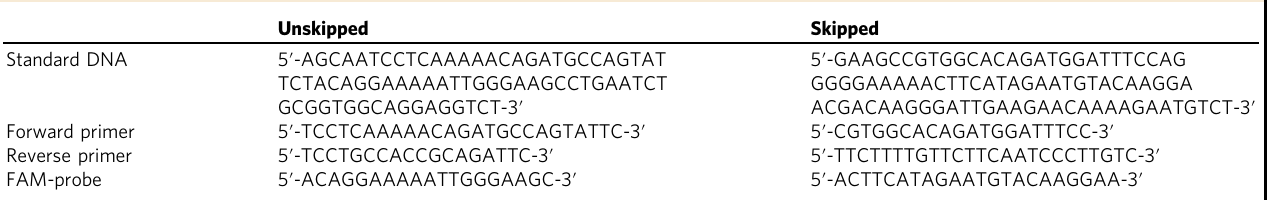
Table 1 Primers used for detecting exon